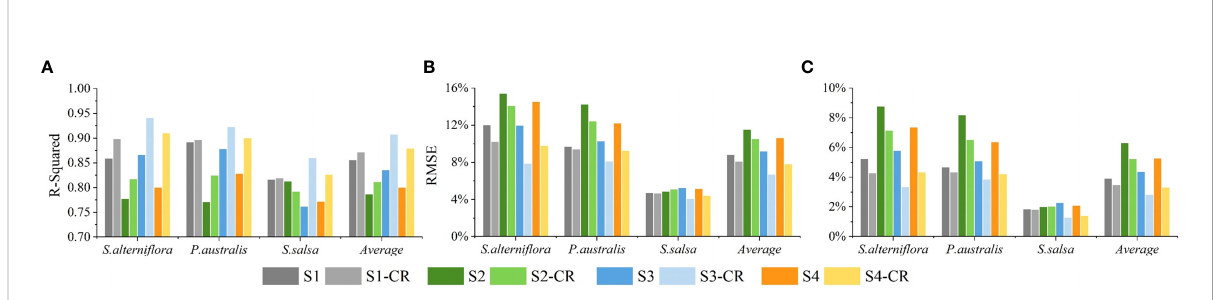
FIGURE 6 (A) R-square, (B) RMSE and (C) MAE of the fractional cover estimation of different salt marsh vegetation species from four scenarios using Gradient Boosting Regression Tree model. S1~S4: Scenario 1 ~ Scenario 4 based on the original Landsat imagery; S1-CR ~ S4-CR: Scenario 1 ~ Scenario 4 based on the cloud-removed Landsat